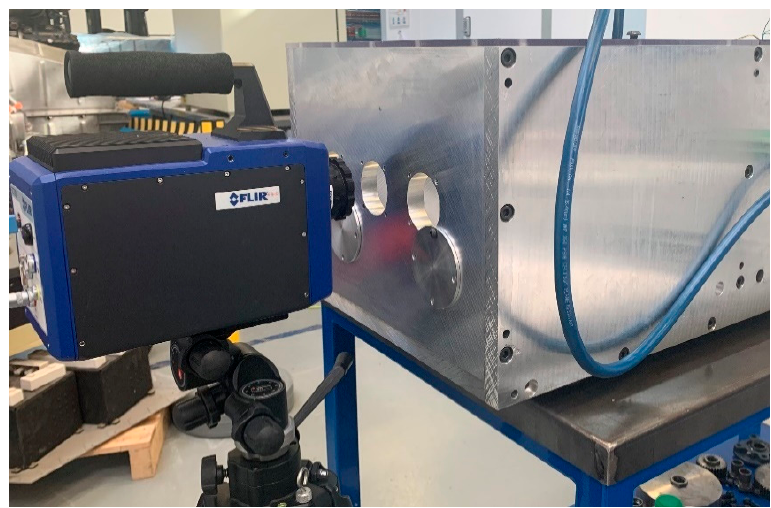
Figure 6. Set up of FLIR thermal imaging camera in front of the seal test bench. The camera used is an infrared thermal imaging camera, IR FLIR MAX (FLIR SC7000, Wilsonville, OR, USA). This particular series allows capturing accurate temperatures (using FLIR Hypercal™) at high frame rates, while preserving sensitivity as